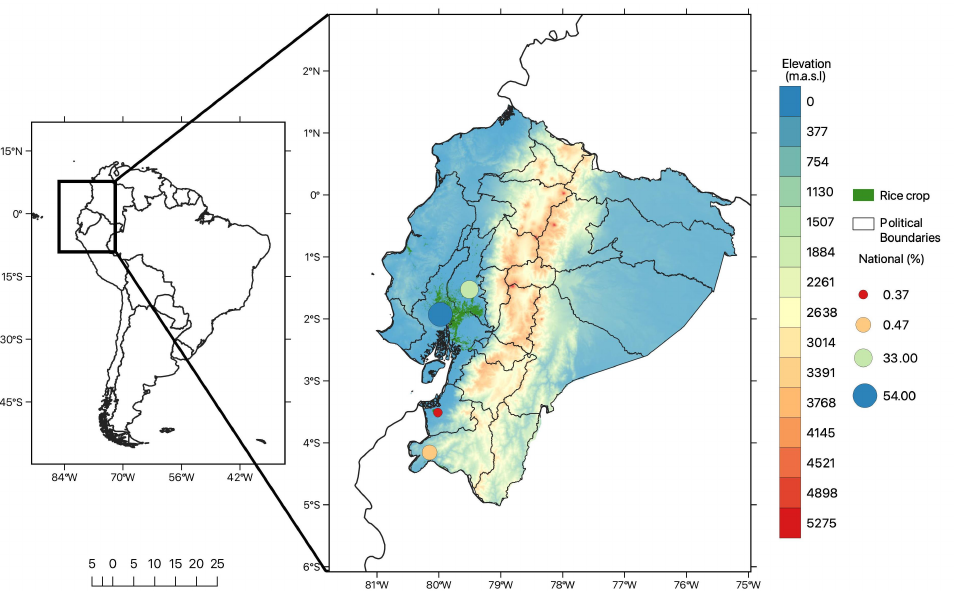
Figure 1. Study region. Spatial distribution of rice crop [32]. The colored dots represent the national percentage (hectares) of the main producing